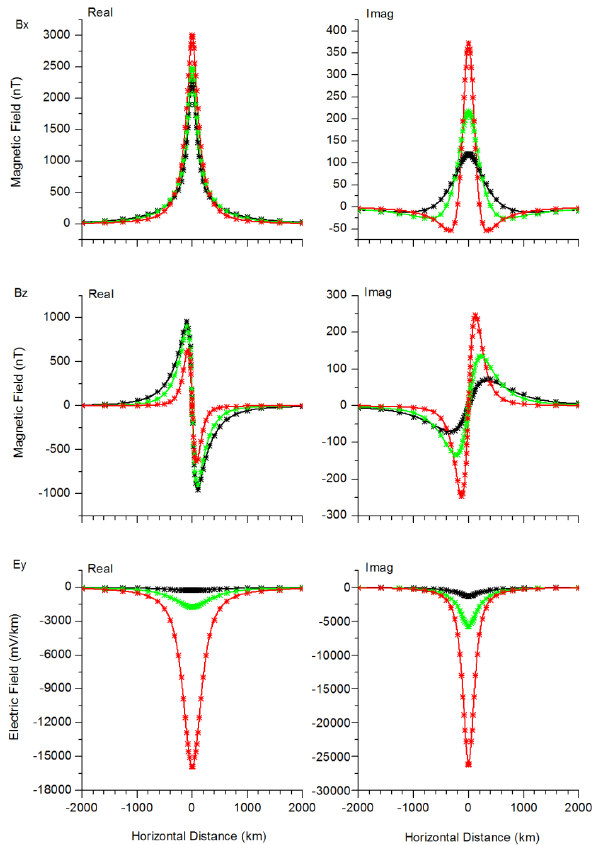
Fig. 4. The electric and magnetic field components at the Earth’s Figure 4. The electric and magnetic field components at the Earth’s surface are shown for the 2 surface are shown for the layered earth conductivity model of Que- bec. The FEM results are the solid curves whereas the FHT results layered earth conductivity model of Quebec. The FEM results are the solid curves whereas 3 are symbols. The colours of the curves represent the periods with the FHT results are symbols. The colours of the curves represent the periods with red being 4 red being 30s, green being 300s and black being 1800s. 30 s, green being 300 s and black being 1800 s. 5